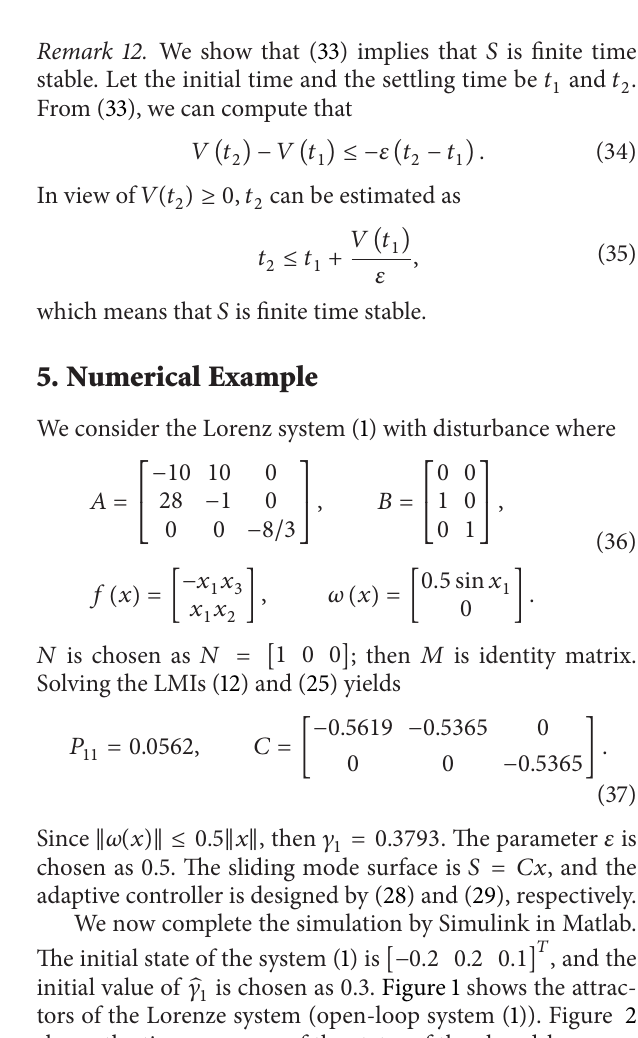
Figure 1: The attractors of Lorenz